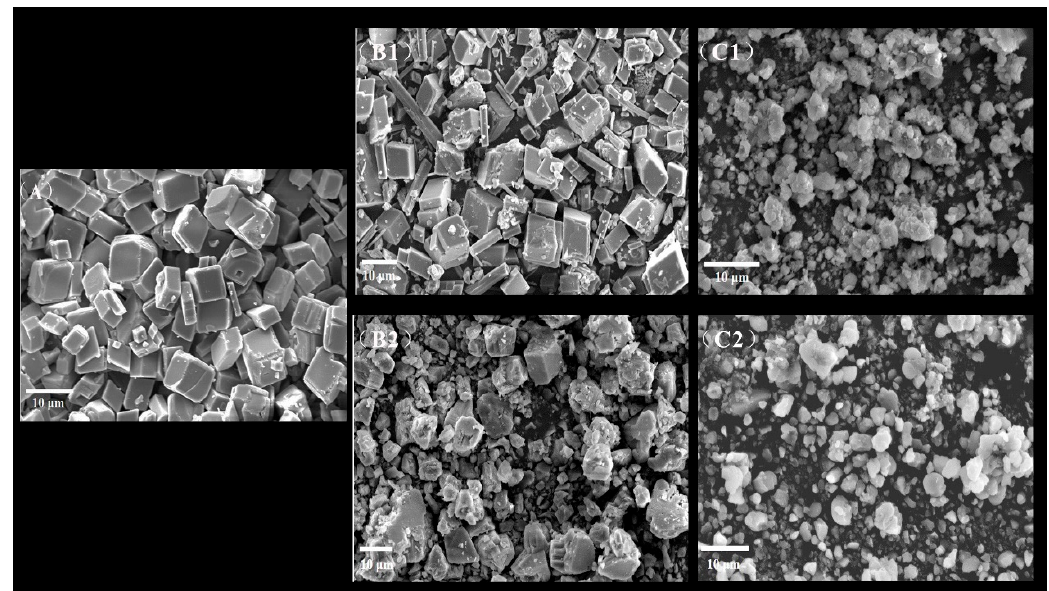
Figure 3. The scanning electron microscopy (SEM) images of CaCO 3 in the absence and presence of PESA and PAA at 80 °C. ( A ) blank, ( B1 and B2 ) ( C1 and C2 ) had 0.67 and 3.33 μ M PESA and PAA, respectively.